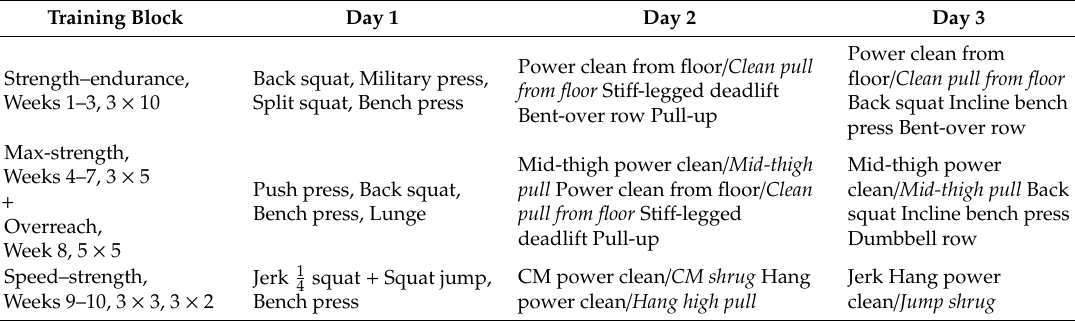
Table 2. Ten week resistance training program including sets × repetitions.